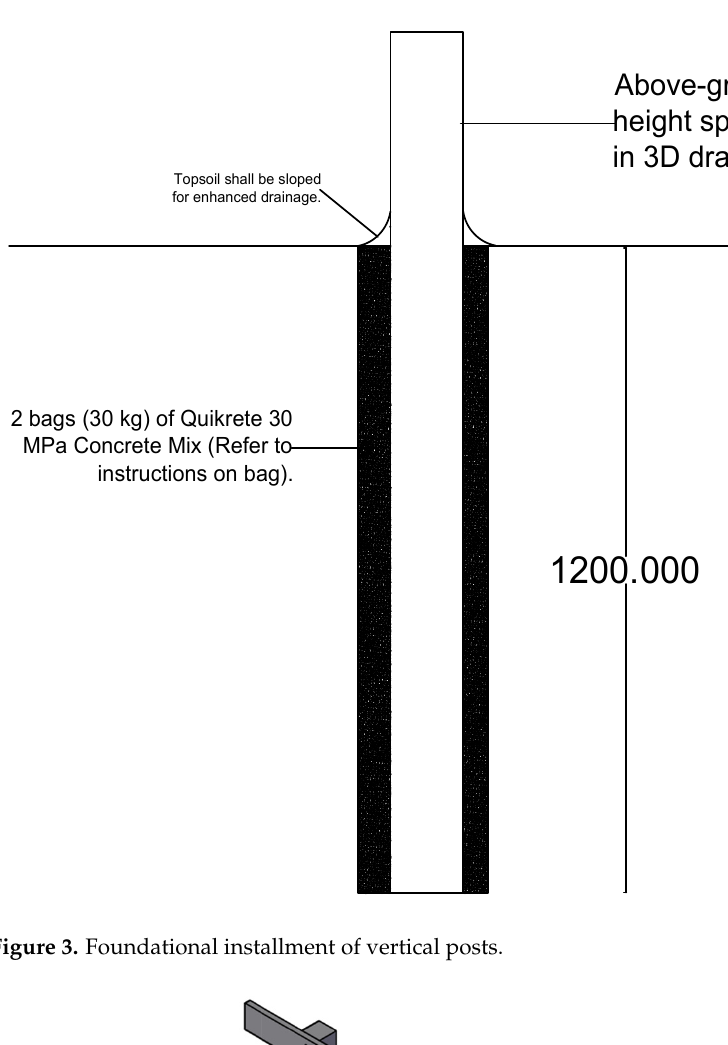
Figure 3. Foundational installment of vertical posts.